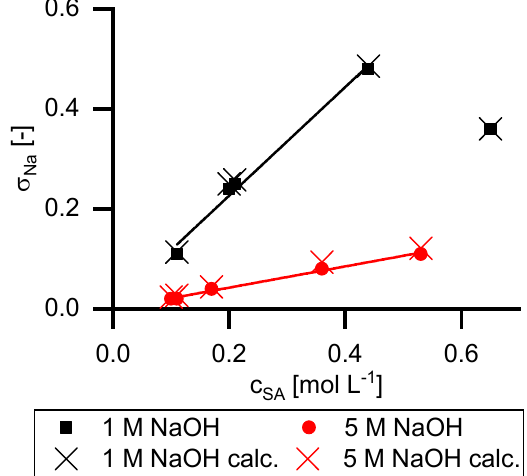
Figure 7. Reflection coefficients of the sodium ions in dependency of succinic acid feed concentration. The dots represent calculated values with the Spiegler and Kedem model, based on experimental data. Crosses represent the calculated reflection coefficients according to Equation (8).